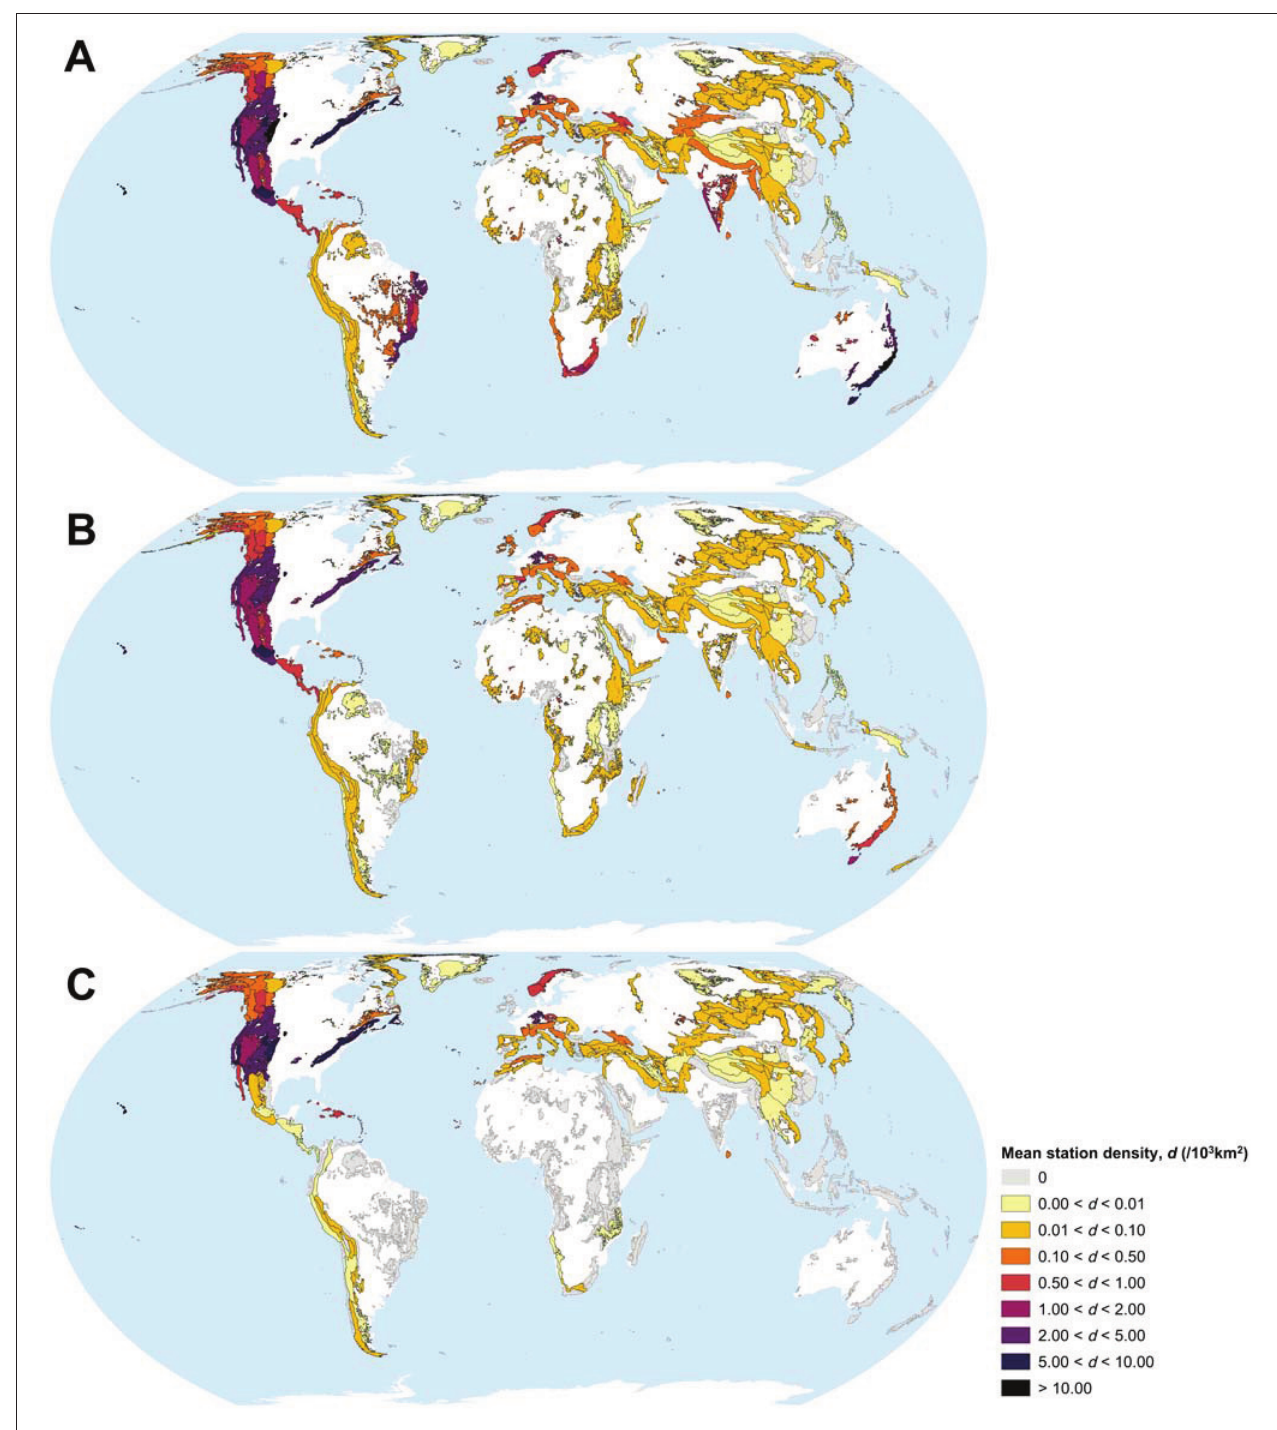
FIGURE 3 | Mean spatial density of GHCNd stations in mountainous terrain for PRCP (A) , TMAX (B) , and SNWD (C) by GMBA mountain polygon, irrespective of record length. The corresponding plot for TMIN is provided in the online Supplementary Material. Whilst the entire GMBA regions are shown, the statistics plotted correspond to only the mountainous parts of these regions, as delineated by Kapos et al. (2000).